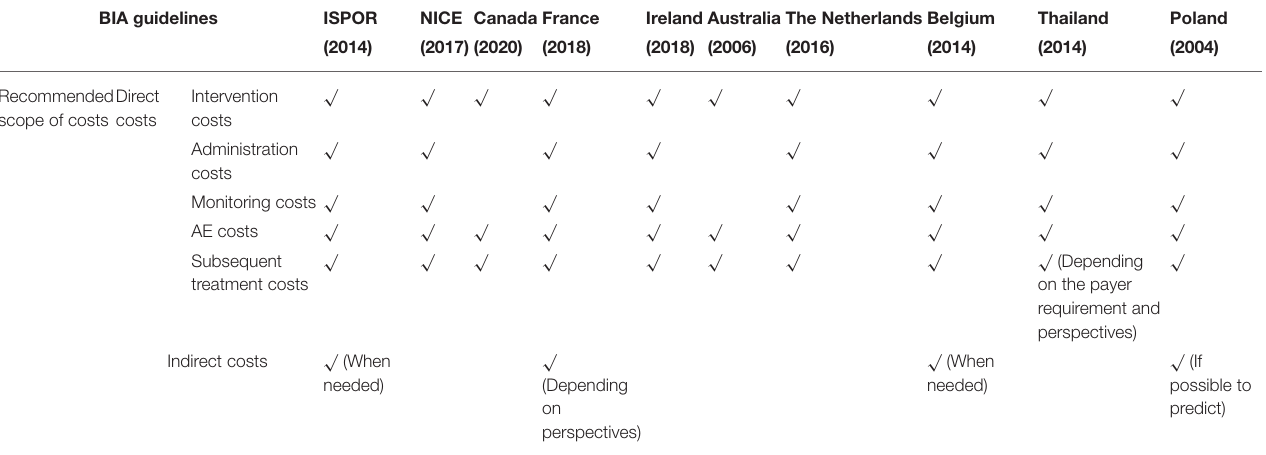
TABLE 2 | Summary of key recommendations of cost scopes in existing BIA